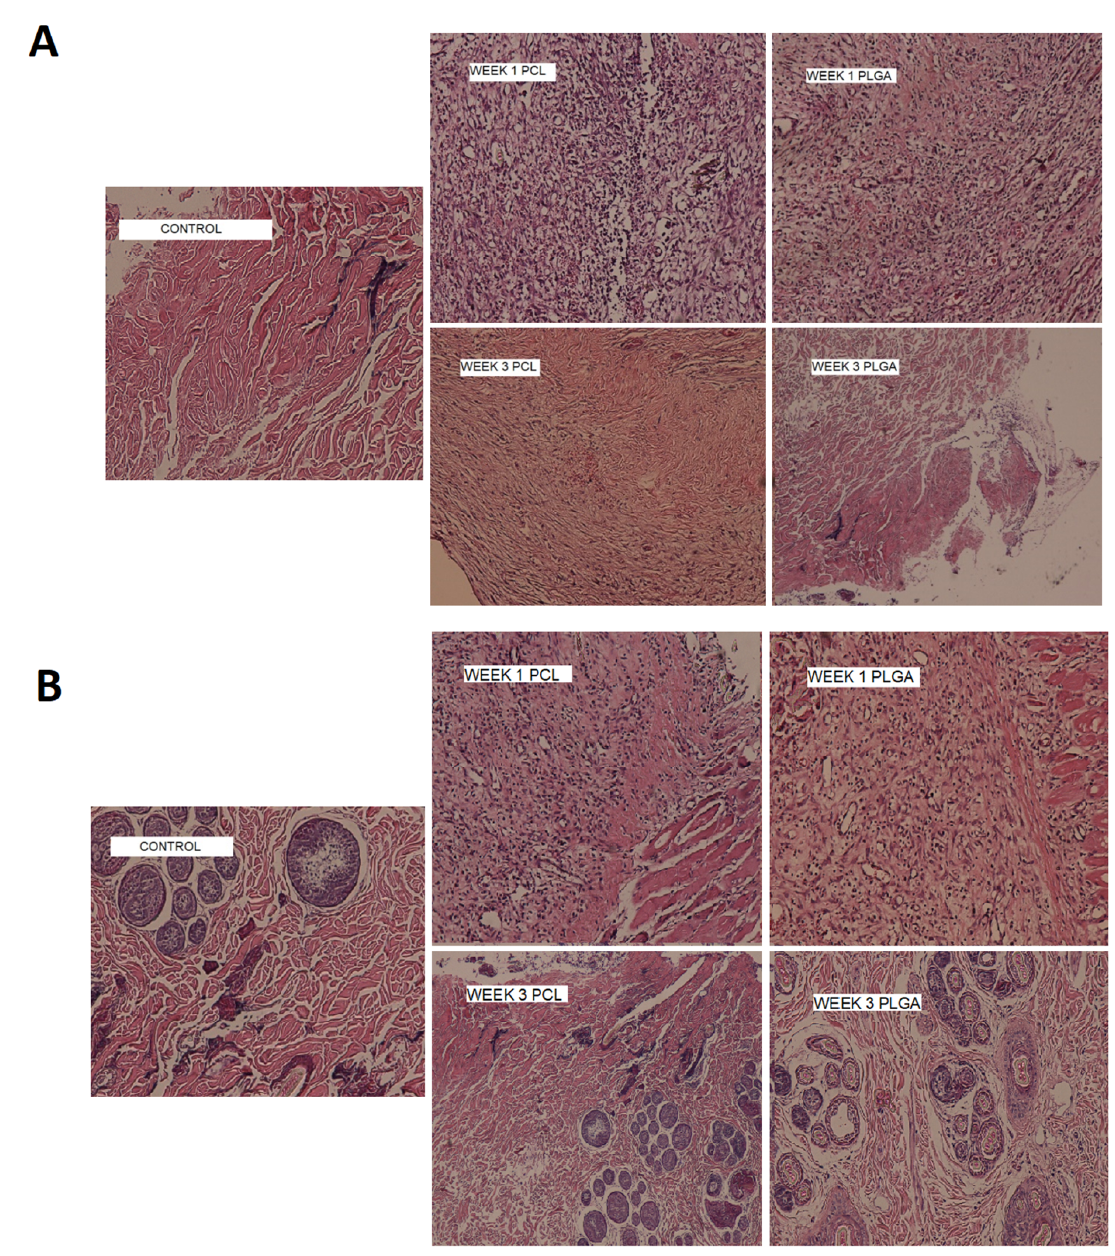
Figure 8. Histopathological changes of subcutaneous tissues after implantation of nanofibers and comparison with control group during 3 weeks in rat model (A) and rabbit model (B).